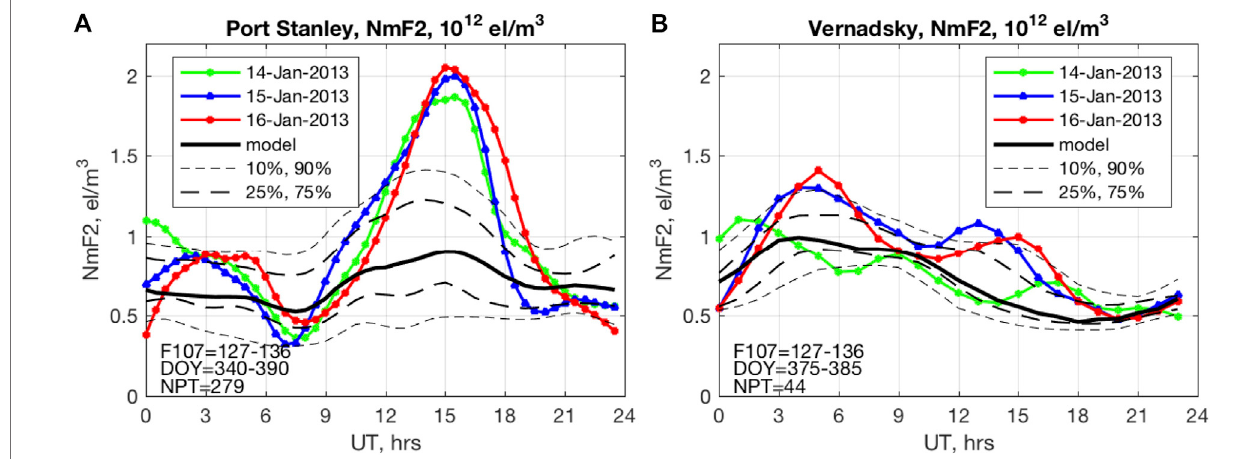
FIGURE4| Variations inthepeak electron density NmF2 asmeasured byionosondes at PortStanley (A) and Vernadsky (B) .Highlyanomalousincreases in NmF2 are observed at both locations during the SSW, as illustrated with data from January 14 – 16, 2013.